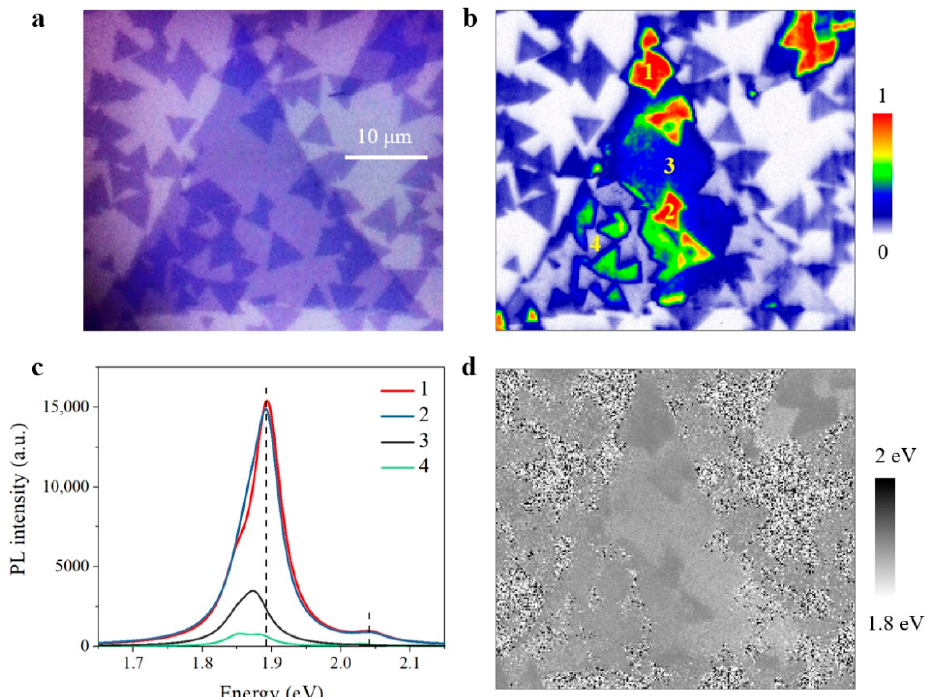
Figure 7. PL mapping of both normal and anomalous twisted MoS 2 bilayers on top of a same bottom monolayer. ( a ) Optical image. ( b ) Normalized PL mapping result in ( a ). ( c ) PL spectra of monolayer, normal bilayer and anomalous bilayer regions marked in ( b ). ( d ) The emission peaks of PL intensity maximum in ( b ).